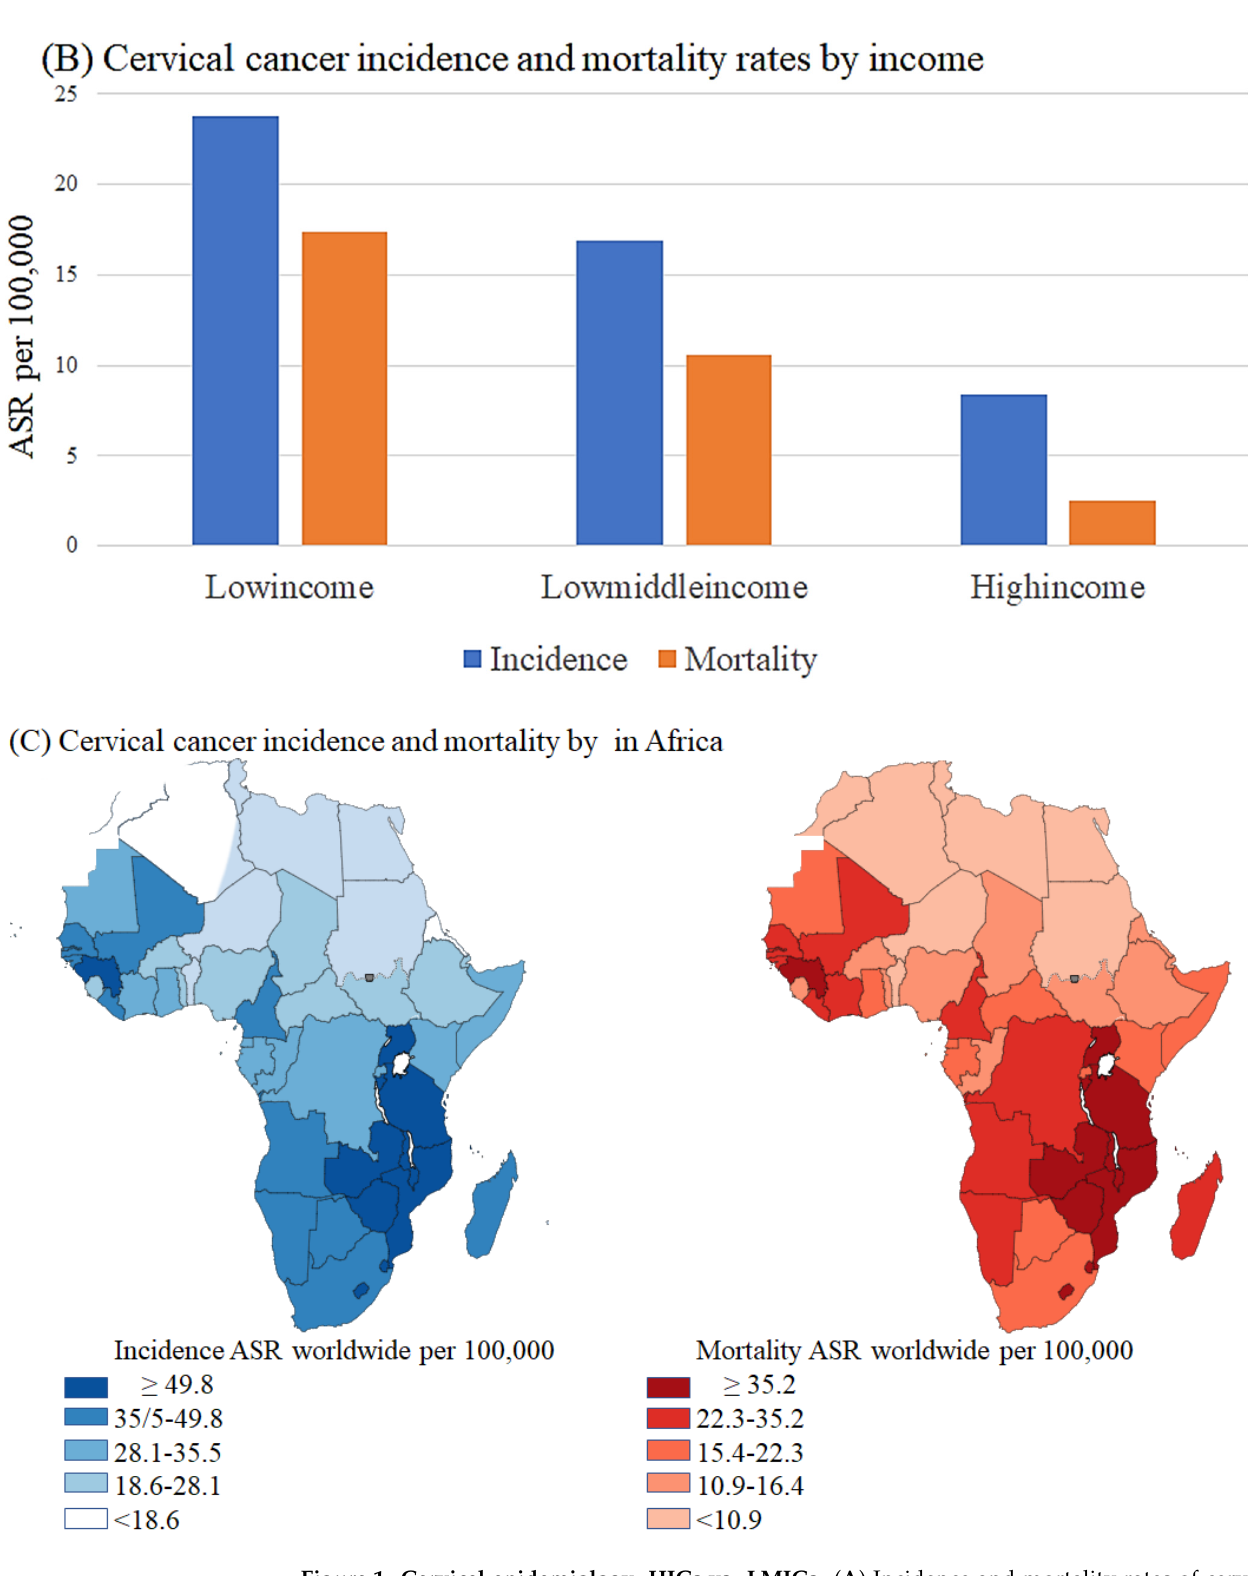
Figure 1. Cervical epidemiology- HICs vs. LMICs . ( A ) Incidence and mortality rates of cervical cancer per region. ( B ) Incidence and mortality rates based on income ( C ) Map depicting the age- standardized rate (ASR) for incidence and mortality per individual country in Africa, representing LMICs [6] .